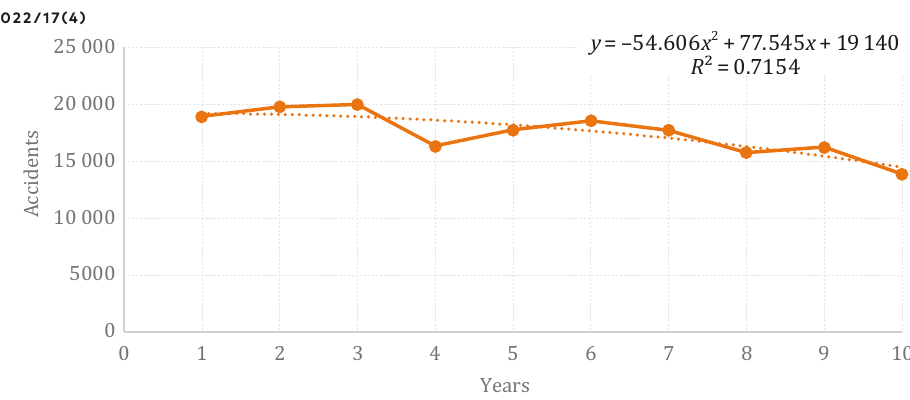
Figure 5. Number of accidents for the period of 2011–2020 associated with a polynomial trend of the 2 nd order